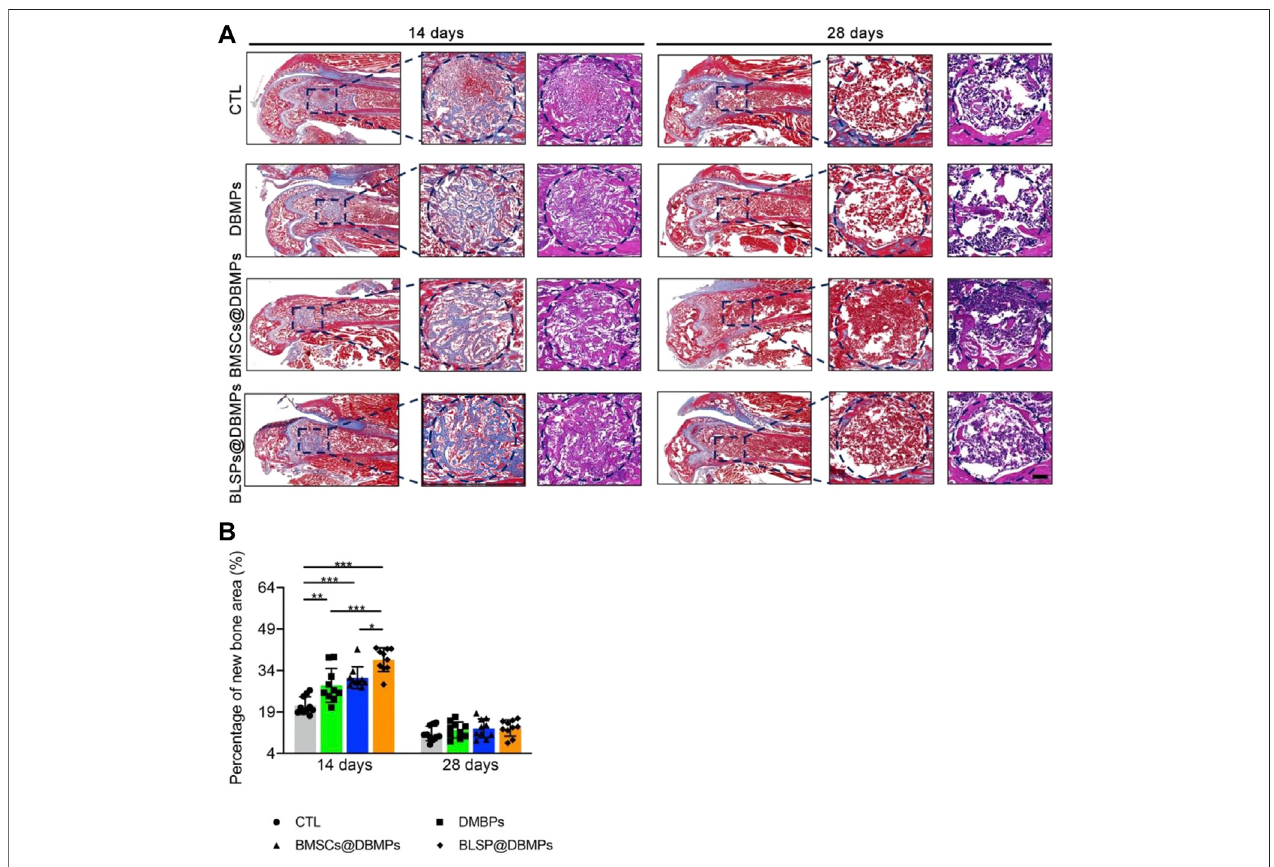
FIGURE7| Histologicalanalysesofregeneratedboneatthedefectsite. (A) Representativeimagesofthenewlyformedboneatthedefectsiteinthesagittalviewat postoperative day 14 or28. The blue dotted circle indicates the defect site. Bar =100 μ m. (B) Percentage ofthenew bone areain therepairedbone defect areaofeach group at postoperative day 14 or 28. n = 10 for each group. Data are showed as means ± standard deviation (* p < 0.05, ** p < 0.01, and *** p < 0.001).